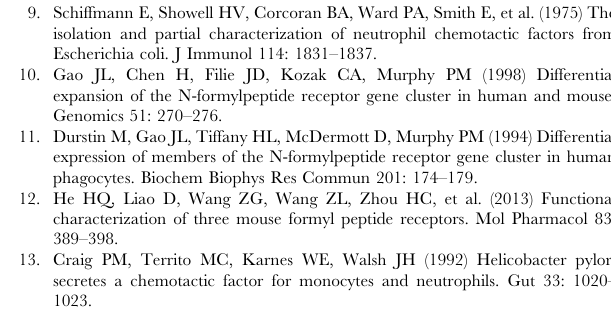
Figure S1 Immunofluorescent staining for CD11b re- veals an increase over time after BDL. CD11b + -cells were visualized using Alexa546. Nuclei were counterstained using